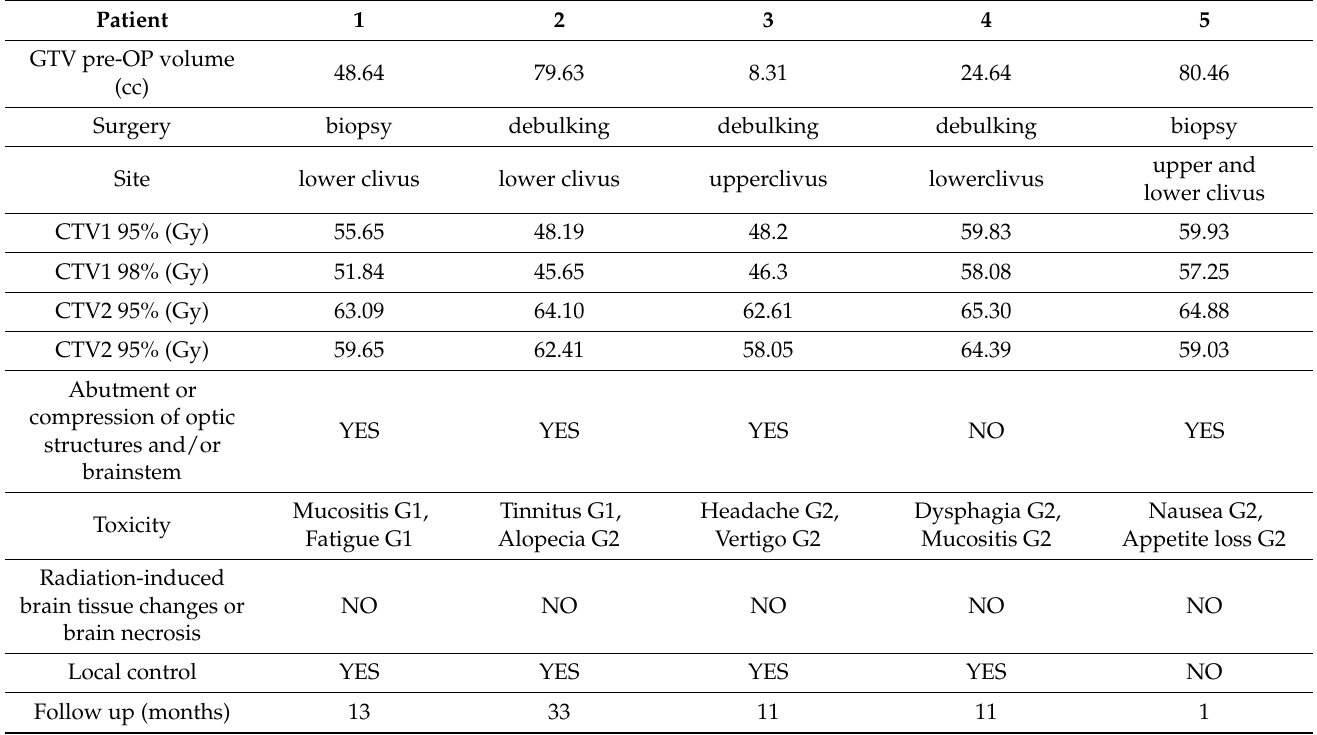
Table 4. Disease and treatment characteristics of five patients treated with carbon ion therapy at